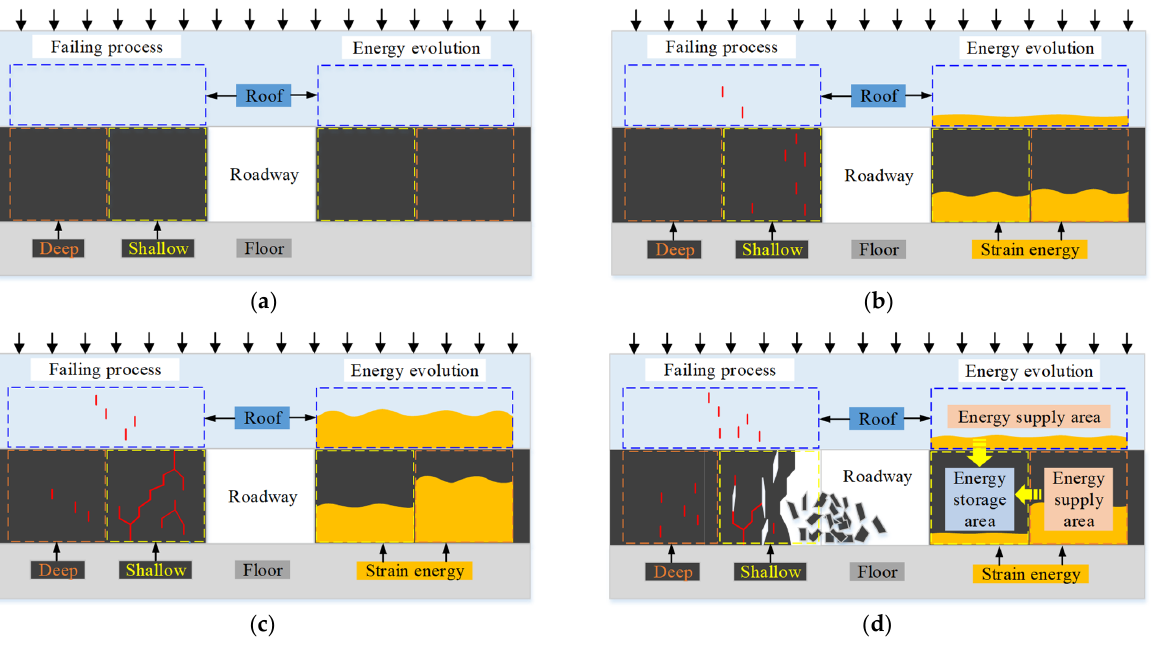
Figure 14. Cloud diagram of strain energy evolution of roadway surrounding rock. ( a ) Strain energy evolution curve of roadway surrounding rock. ( b ) Strain energy evolution range of roadway surrounding rock.